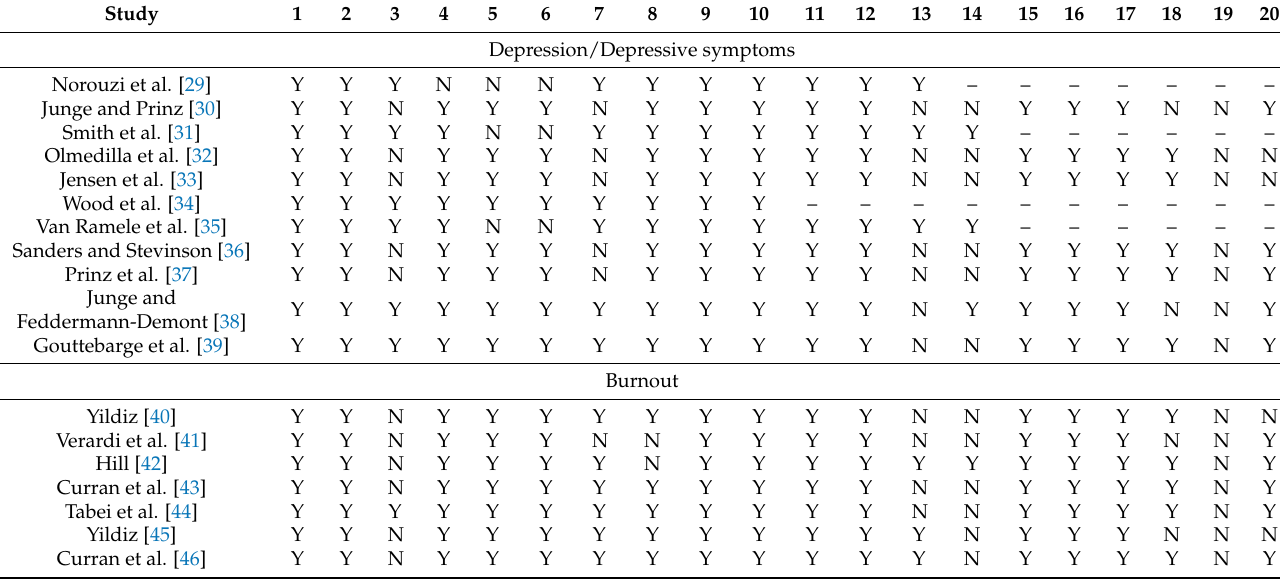
Table 1. Quality assessment of individual studies.